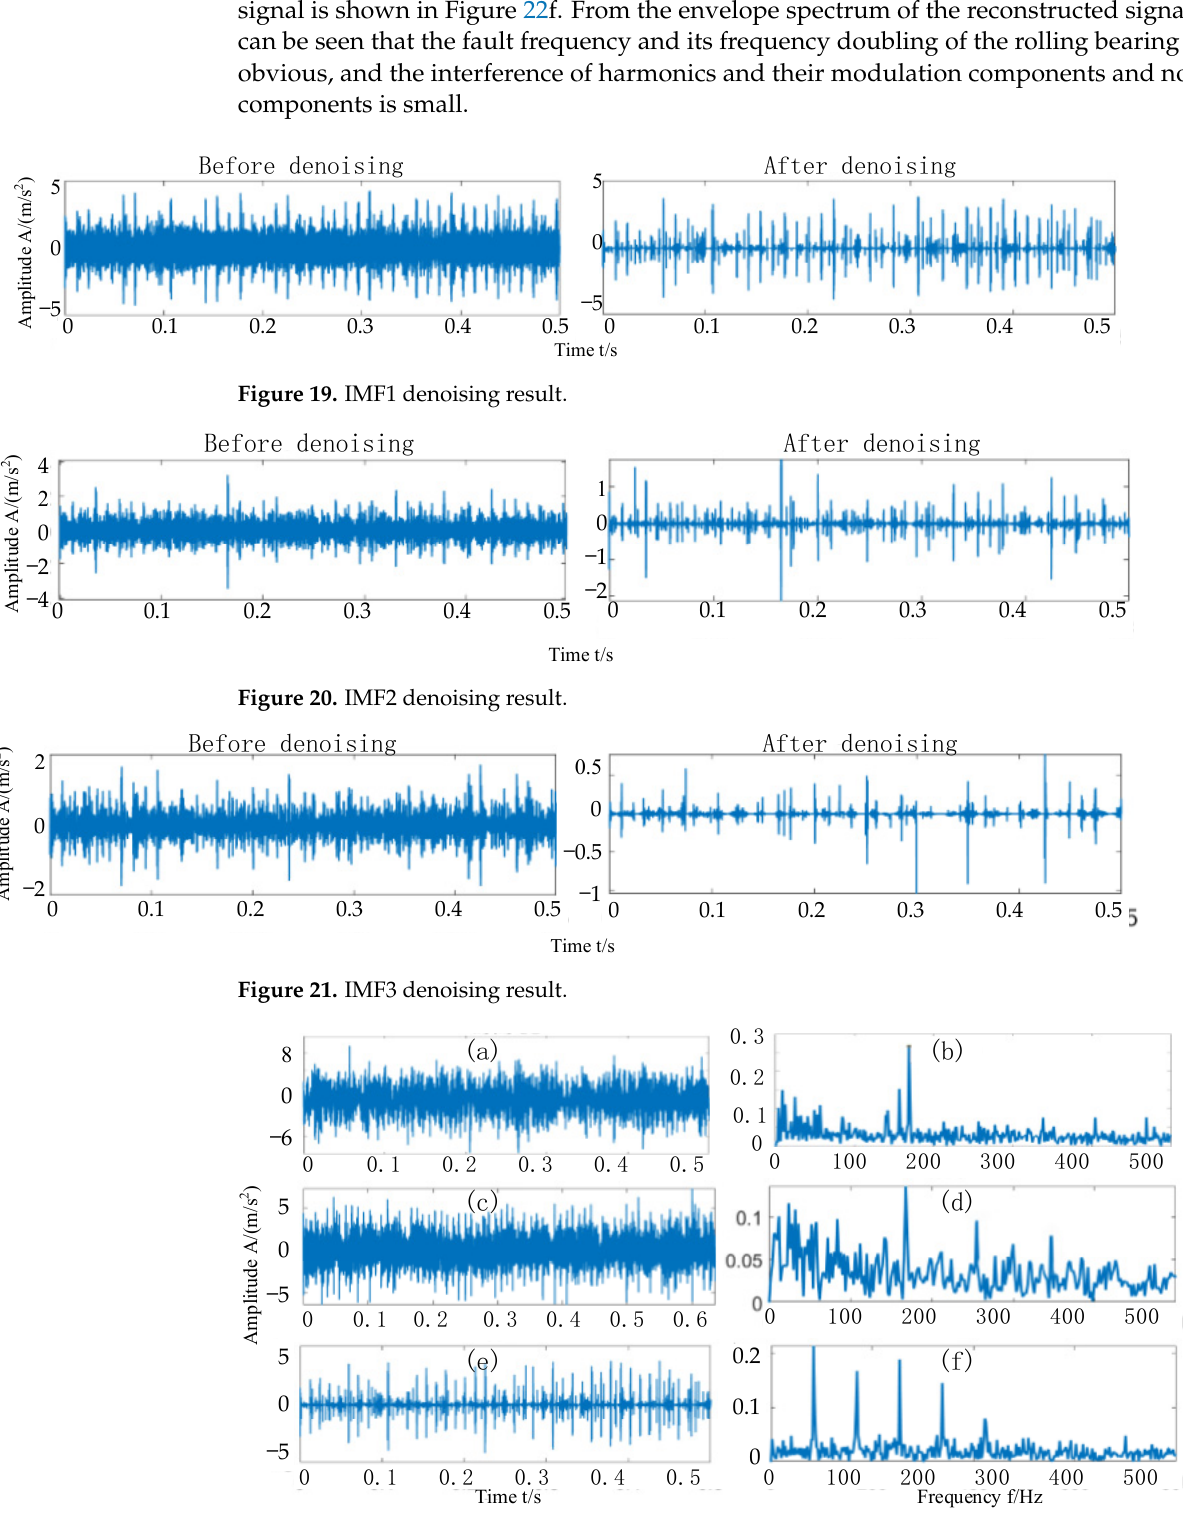
Figure 22. Signal processing results of different methods. ( a ) Direct time-domain analysis of signals; ( b ) Direct frequency domain analysis of signals; ( c ) Time-domain analysis of signals using improved sparse representation algorithm; ( d ) Frequency-domain analysis of signals using improved sparse representation algorithm; ( e ) Time-domain analysis of the signal using the algorithm in this paper; and ( f ) Frequency domain analysis of the signal using the algorithm in this paper.